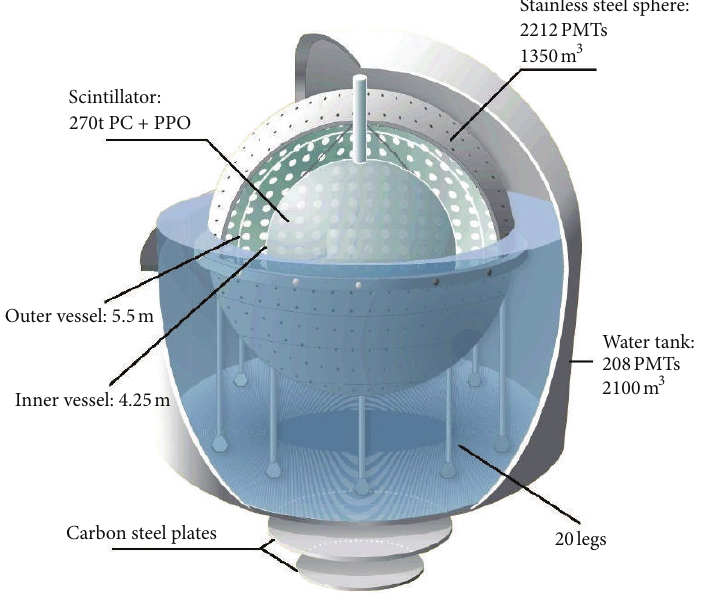
Figure 8: Schematic view of the Borexino detector.